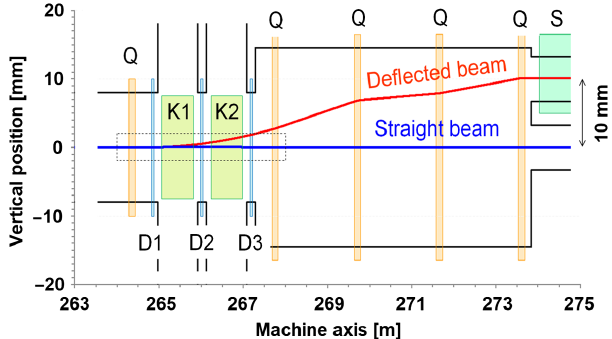
FIG. 12. Beam trajectory in the switchyard with the corre- sponding deflecting field regions. Q denotes quadrupole magnets, K1, K2-resonant kickers, D1, D2, and D3-compensating dipole magnets, and S-the